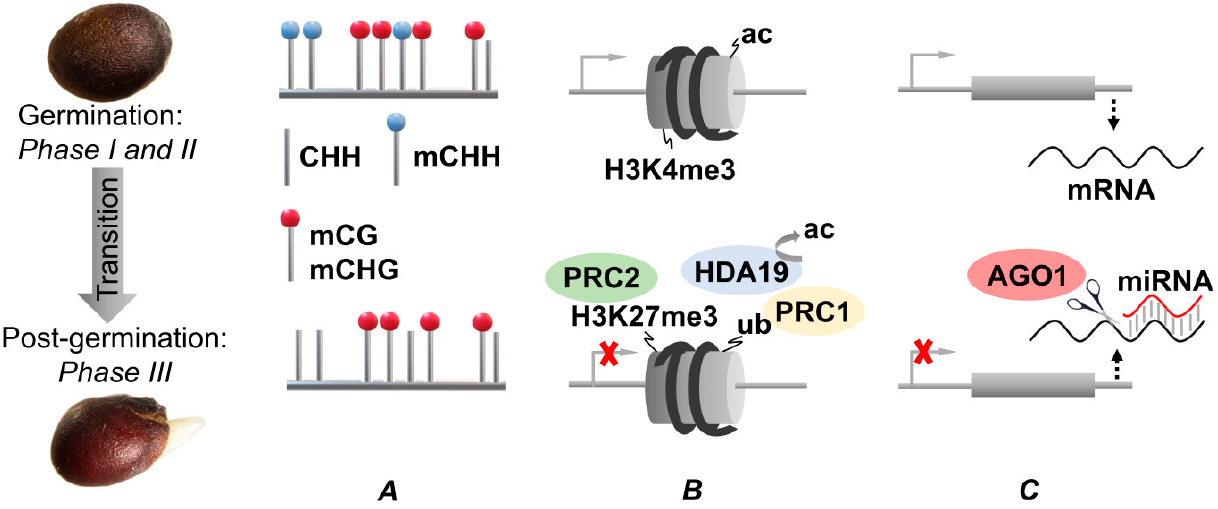
Figure 2. Epigenetic modifications accompanying the transition from germination to the post-germination stage of plant development. ( A ) Methylation of cytosines in DNA. CHH methylation (mCHH) is gradually lost during germination. In contrast, CG and CHG methylation (mCG and mCHG) mostly remain stable. ( B ) Histone post-translational modifications. The genes involved in seed maturation and dormancy are repressed by trimethylation of K27 in histone H3 by PRC2 and ubiquitination at K119 of histone H2A by monoubiquitin ligase PRC1. The repression of the target gene is initiated by recruitment of histone deacetylase 19 (HDA19) by VAL proteins to remove histone acetylation marks and PRC1 to incorporate the H2A ubiquitine marks. Upon its onset, stable repression of the target genes can be constantly maintained by PRC2-mediated trimethylation of K27 in histone H3. ( C ) Post-transcriptional downregulation of target genes. miRNAs (red wavy line) block the expression of the genes involved in development and dormancy genes by cleavage of their mRNAs with Argonaute1 (AGO1)